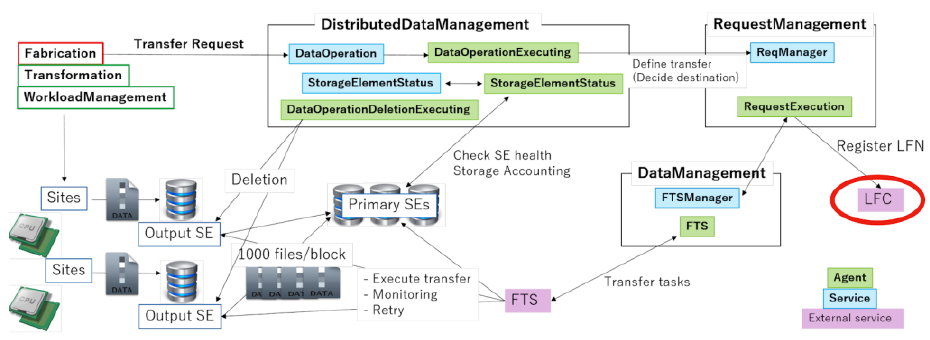
Fig. 2. The Belle II Distributed Data Management System (DDM) and its interaction with the other components, such as the Fabrication system that makes transfer requests to DDM, the DIRAC RequestManagement and DataManagement systems which interact with FTS and LFC, and the SEs hosted at the sites. FTS performs file transfers between SEs, while DDM executes file deletion at the source SEs after transfers.